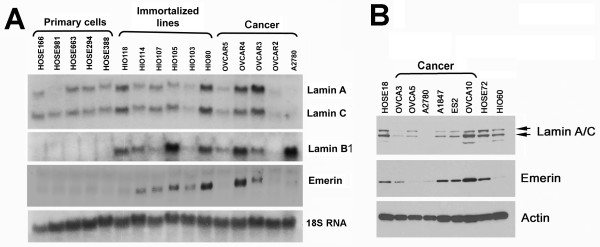
Expression of nuclear envelope proteins in ovarian epithelial and cancer cell lines. Primary non-cancer cells and cancer cell lines were analyzed for mRNA and protein expression of nuclear envelope proteins lamin A/C, lamin B1, and emerin. (A) Total RNA was isolated and analyzed by Northern blot of primary human ovarian surface epithelial cells (HOSE166, HOSE981, HOSE663, HOSE294, and HOSE388), immortalized lines (HIO118, HIO114, HIO107, HIO105, HIO80), and ovarian cancer cells (OVCAR8, OVCAR4, OVCAR3, OVCAR5, and A2780) for the expression of lamin A/C, lamin B1, and emerin. (B) Total cell lysates from two lines of primary ovarian surface epithelial cells (HOSE18, HOSE72), an immortalized line (HIO60), and six ovarian cancer lines (OVCAR3, OVCAR5, OVCAR10, A2780, A1847, and ES2), were prepared from cultures for Western blot analysis.